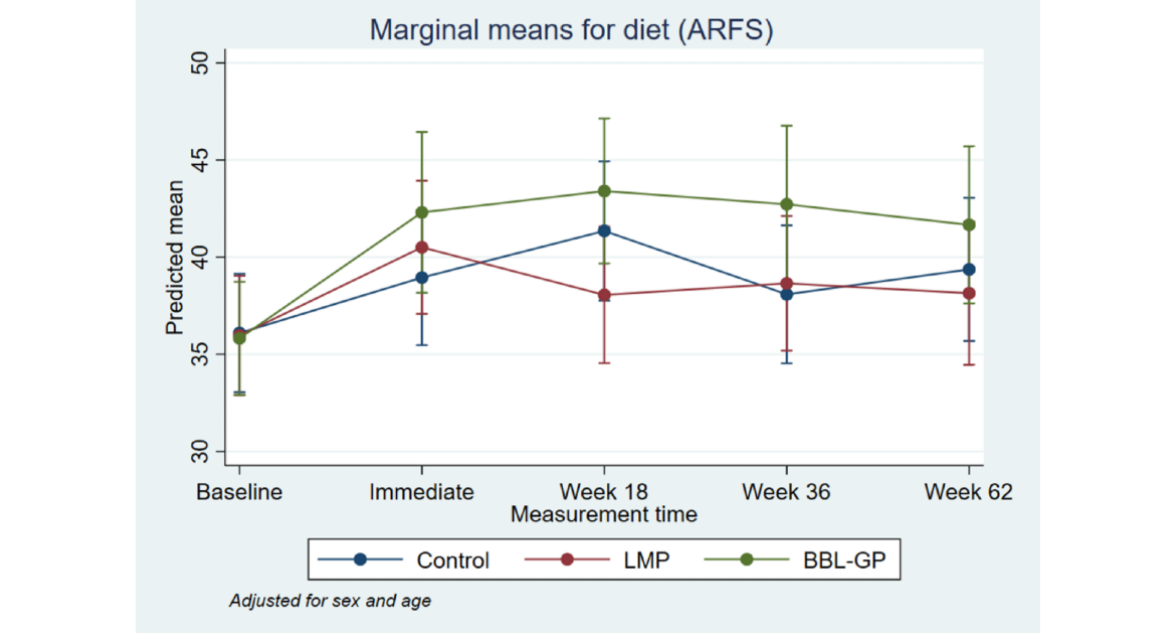
Figure 7. Mean Diet Score (ARFS) with 95% CI, by time point and intervention group. ARFS: Australian Recommended Food Score; BBL-GP: Body Brain Life in General Practice; LMP: Lifestyle Modification Program; PSQI: Pittsburgh Sleep Quality